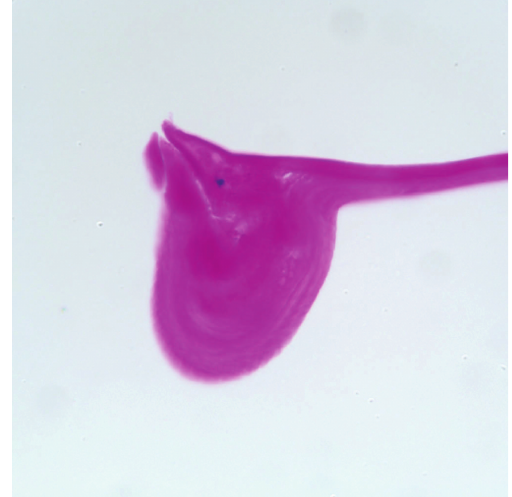
Figure 3: Histopathology of the stripped Descemet’s membrane demonstrating an area of nodular thickening of Descemet’s mem- brane composed of concentric scrolls of PAS-positive material (periodic acid-schi ff stain, original magnification